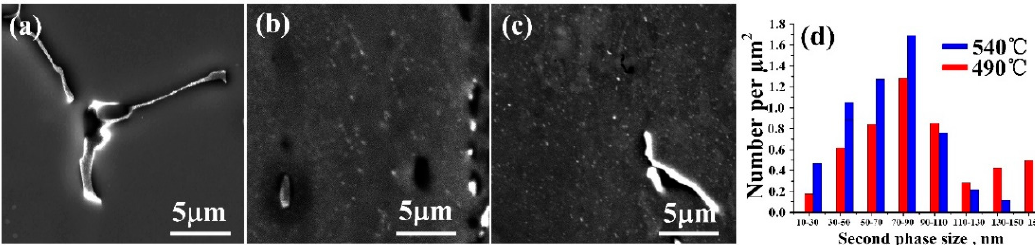
Figure 7. Images of second phases in the WQ ( a ) and RQ ( b ) ( c ) samples prior to ageing; ( a ) ( c ) preheated at 540 °C, ( b ) at 490 °C; ( d ) The size distribution of precipitates in RQ processed alloy preheated at 540 °C and 490 °C.